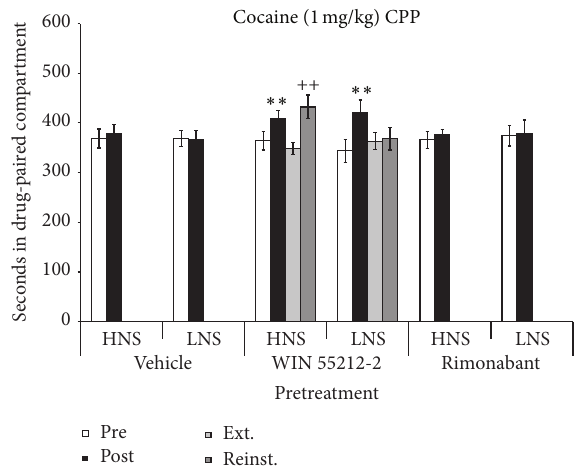
Figure3:EffectsofWIN55212-2(0.05and0.075 mg/kg)ontheCPP paradigm in HNS and LNS adolescent mice (HNS 0.05, 𝑛 = 12 ; LNS 0.05, 𝑛 = 12 ; HNS 0.075, 𝑛 = 13 ; LNS 0.075, 𝑛 = 14 ). Bars represent time in seconds spent in the drug-paired compartment during preconditioning (white), postconditioning (black), the last extinction session (light grey), and reinstatement (dark grey). Values are mean ± SEM. ∗ 𝑝 < 0.05 , difference with respect to the preconditioning session.